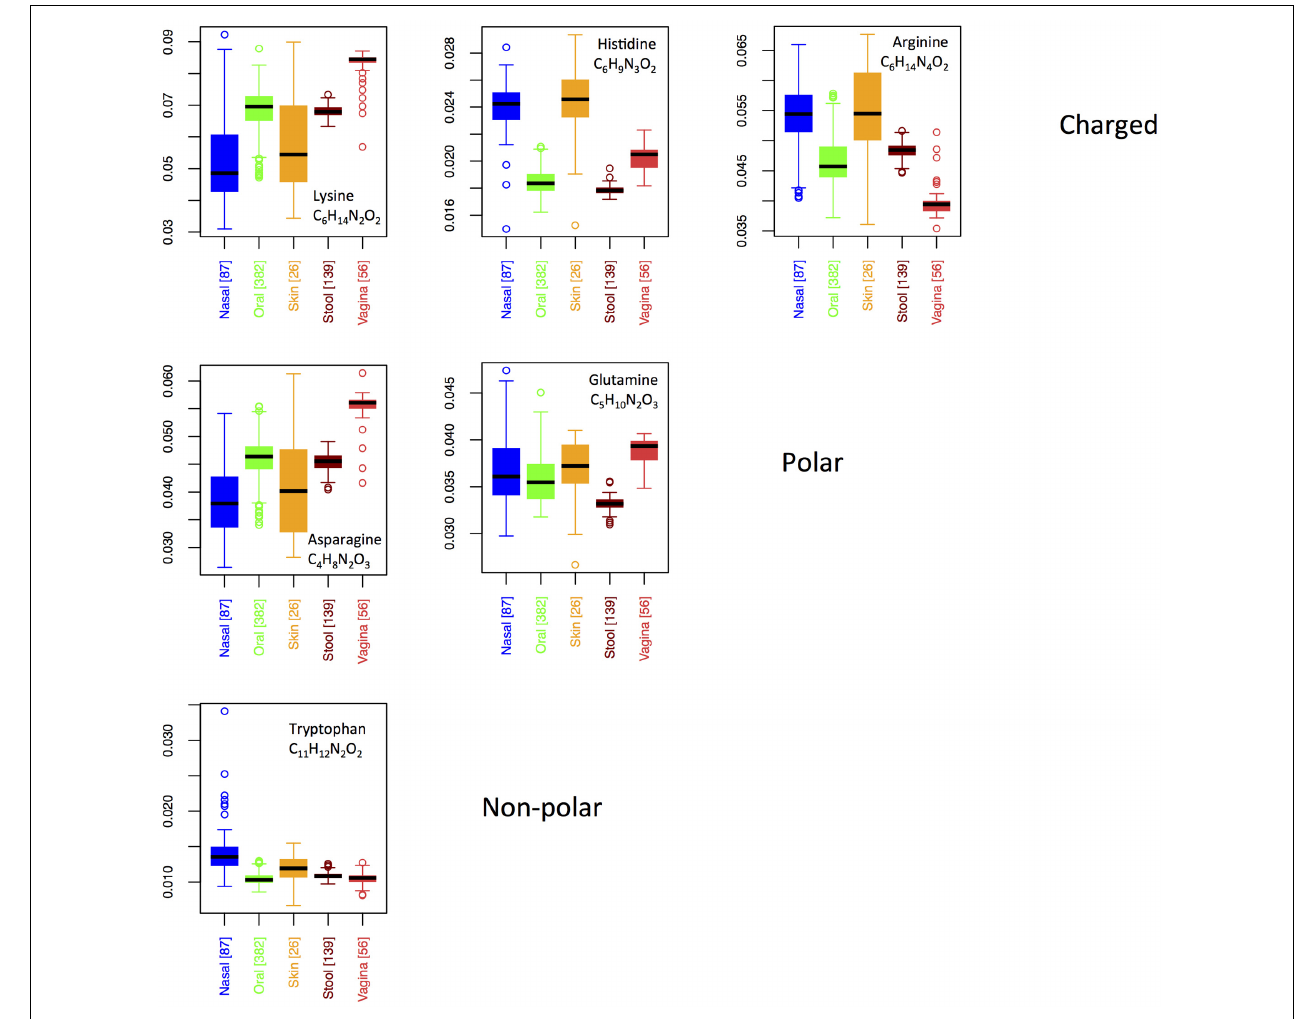
FIGURE 6 | Boxplots showing the fractions of specific N-rich amino acids as a function of body site. Amino acids are grouped according to their chemical